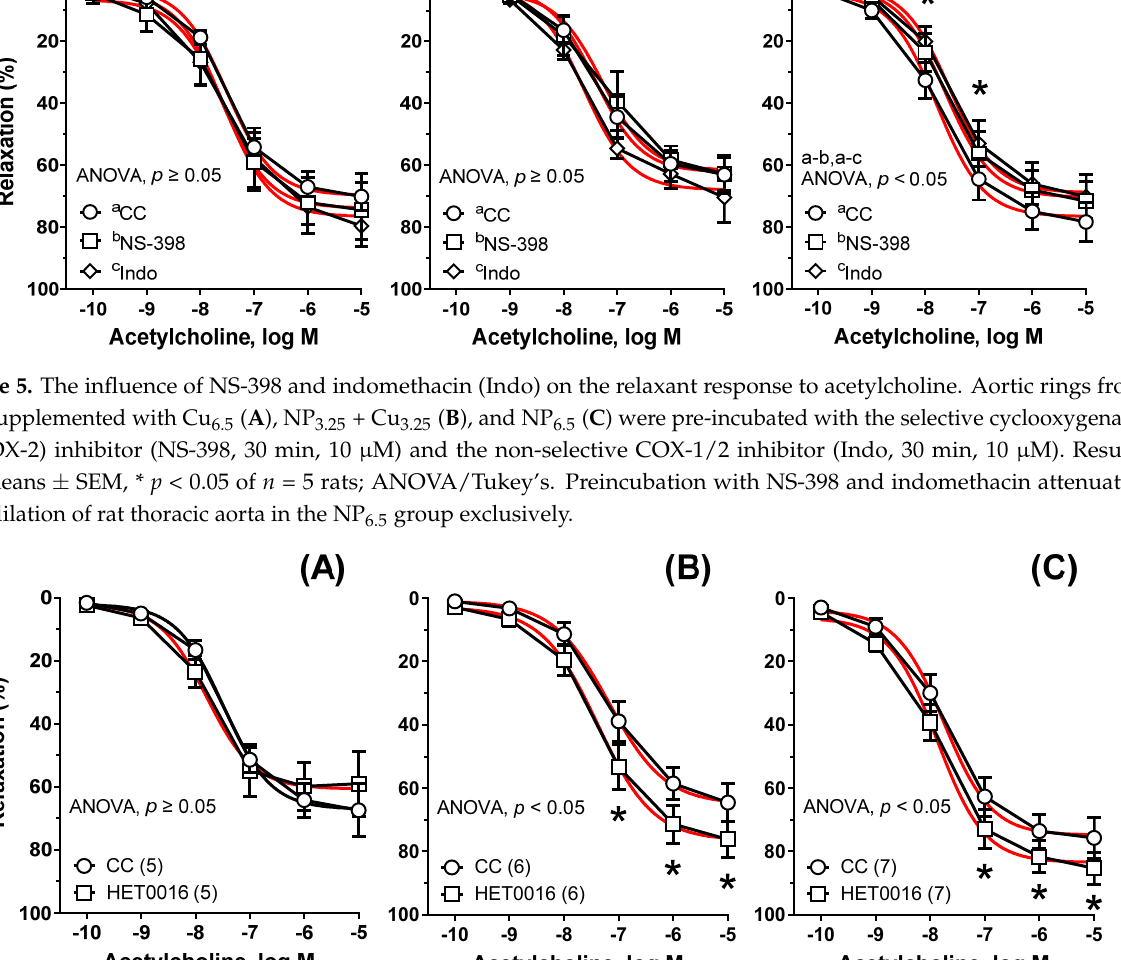
Figure 6. The influence of HET0016 on the relaxant response to acetylcholine. Aortic rings from rats supplemented with Cu 6.5 ( A ), NP 3.25 + Cu 3.25 ( B ), and NP 6.5 ( C ) were pre-incubated with an inhibitor of 20-HETE formation (HET0016, 30 min, 0.1 µM). Results are the means ± SEM, * p < 0.05 two-way ANOVA/Sidak’s. Number of animals is indicated in parenthesis. Preincubation with HET0016 potentiated vasodilation in NP 3.25 + Cu 3.25 , and NP 6.5 fed rats. This was not observed in the control group (Cu 6.5 ).